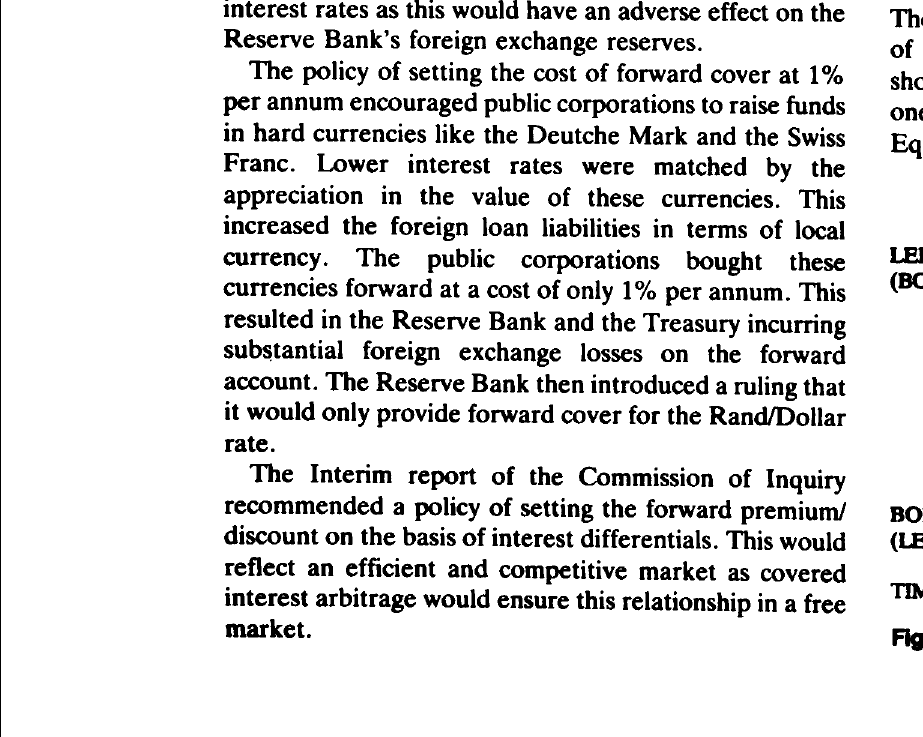
Figure 1 Covered interest arbitrage